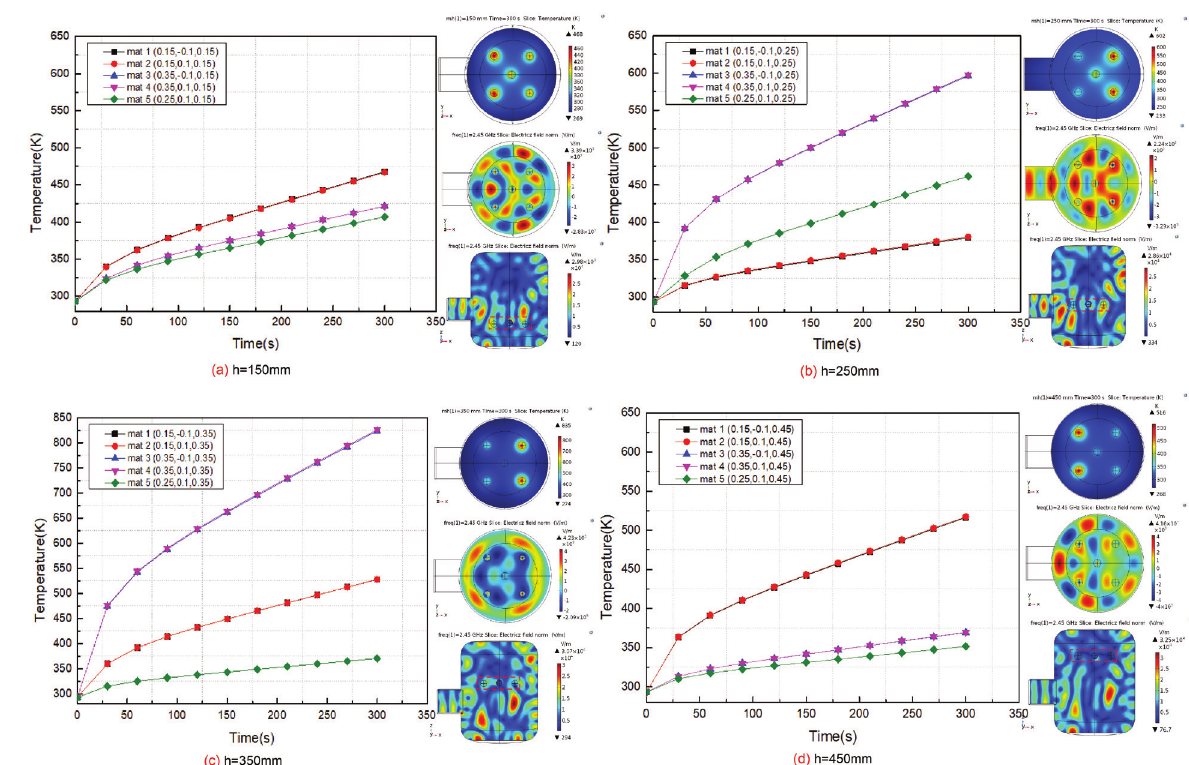
Figure 5: Influence of the variations of height on the heating rate and temperature distribution, combination